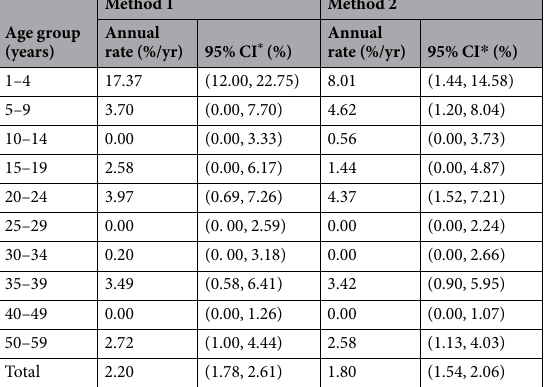
Table 3. Estimated annual rates of HBsAg seroclearance in chronic HBV infections of China. Note. CI, confidence interval; HBsAg, hepatitis B surface antigen; HBV, hepatitis B virus. * If the lower limit value of confidence interval was negative, then it was set to 0.00.